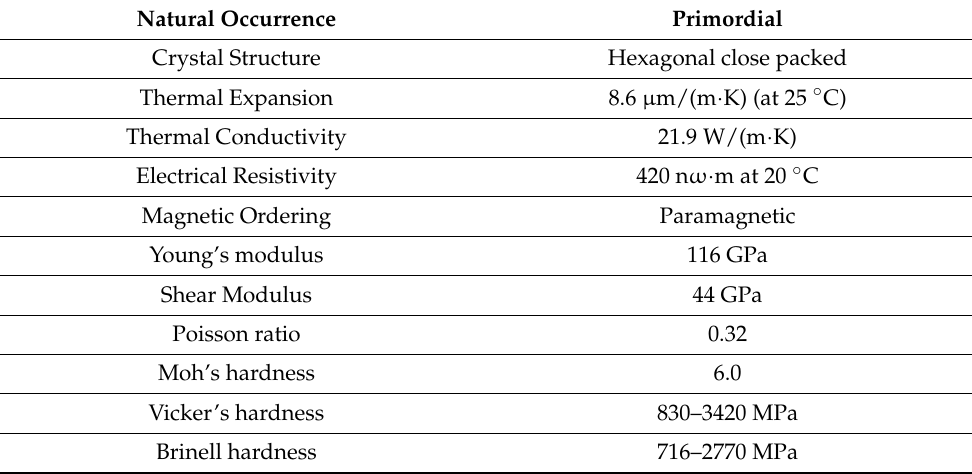
Table 2. Mechanical properties of Titanium [32].